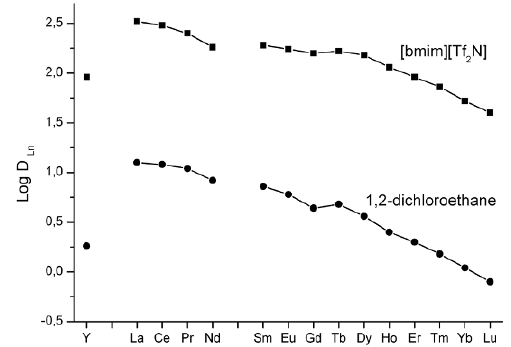
Figure 7. The extraction of lanthanides(III) from 3 M HNO with 0.01 M solutions of compound 1 in 1,2-dichloroethane and [bmim][Tf 2